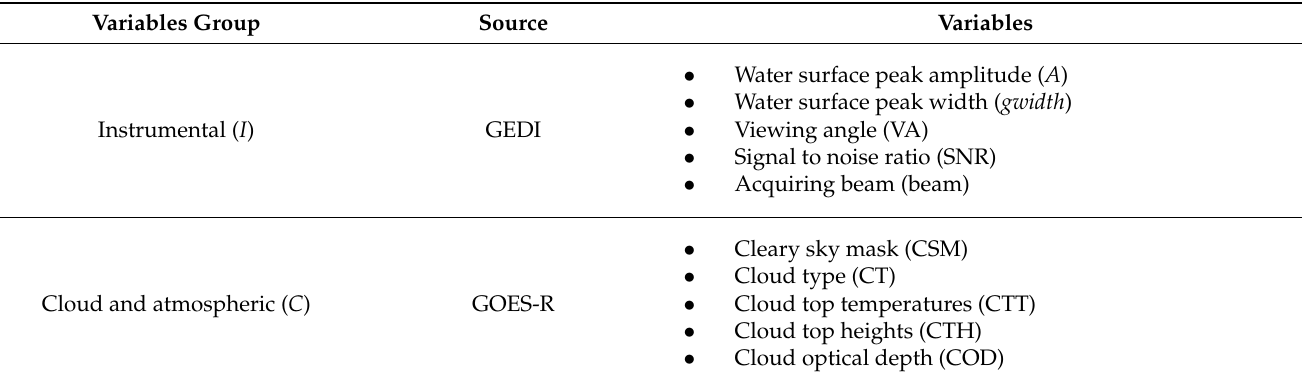
Table 2. Summary of the three groups of factors used in this study for the correction of GEDI elevation